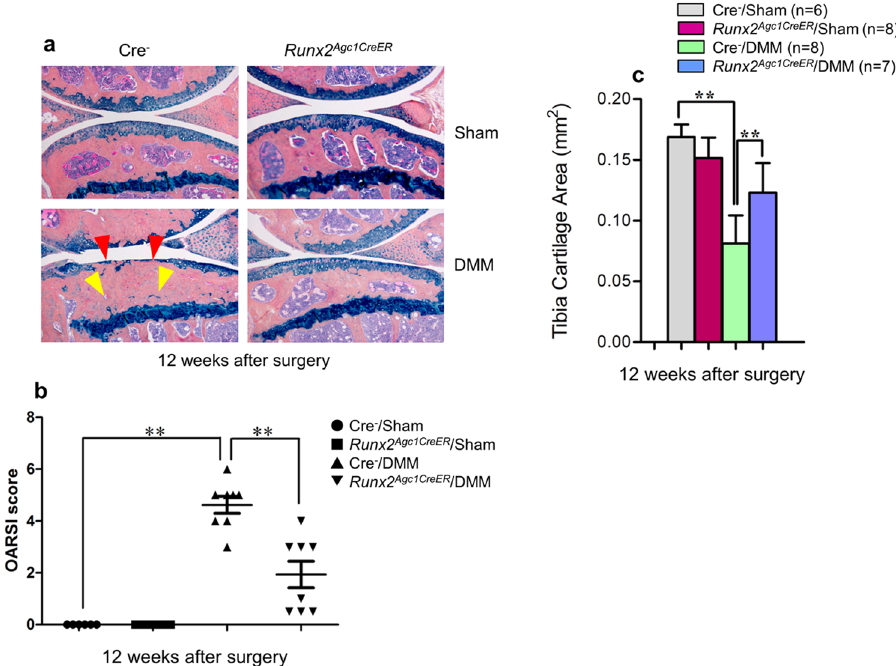
Figure 3. OA progression was protected in Runx2 Agc1CreER mice 12 weeks after DMM surgery. ( a ) Knee joints were harvested from Cre-negative and Runx2 Agc1CreER KO mice 12 weeks post-surgery and Alcian blue/ Hematoxylin Orange G staining was performed. Histological results showed that articular cartilage degradation (red arrowheads) and subchondral sclerosis (yellow arrowheads) were observed in Cre-negative control mice after DMM surgery. In contrast, defects in articular cartilage degradation and subchondral sclerosis induced by DMM surgery was significantly protected in Runx2 Agc1CreER mice. ( b ) Histological sections were analyzed by OARSI scoring system. The severity of OA-like phenotype was graded by OARSI scoring system by two blinded observers. The results demonstrated that DMM surgery caused significant OA-like defects in Cre-negative control mice. In contrast, DMM-induced OA-like defects (12-weeks post-surgery) were significantly protected in Runx2 Agc1CreER KO mice ( ** P < 0.01, one-way ANOVA followed by Tukey’s post-hoc test; n = 6–8 mice per group). ( c ) Histological sections were analyzed by histomorphometric method. Articular cartilage area of tibia plateau was quantified by tracing the Alcian blue-positive staining areas using the OsteoMeasure system. DMM surgery led to significant loss of articular cartilage in Cre-negative control mice. In contrast, this effect was significantly protected by deletion of Runx2 observed in Runx2 Agc1CreER KO mice (12-weeks after DMM surgery) ( ** P < 0.01, one-way ANOVA followed by Tukey’s post-hoc test; n = 6–8 mice per